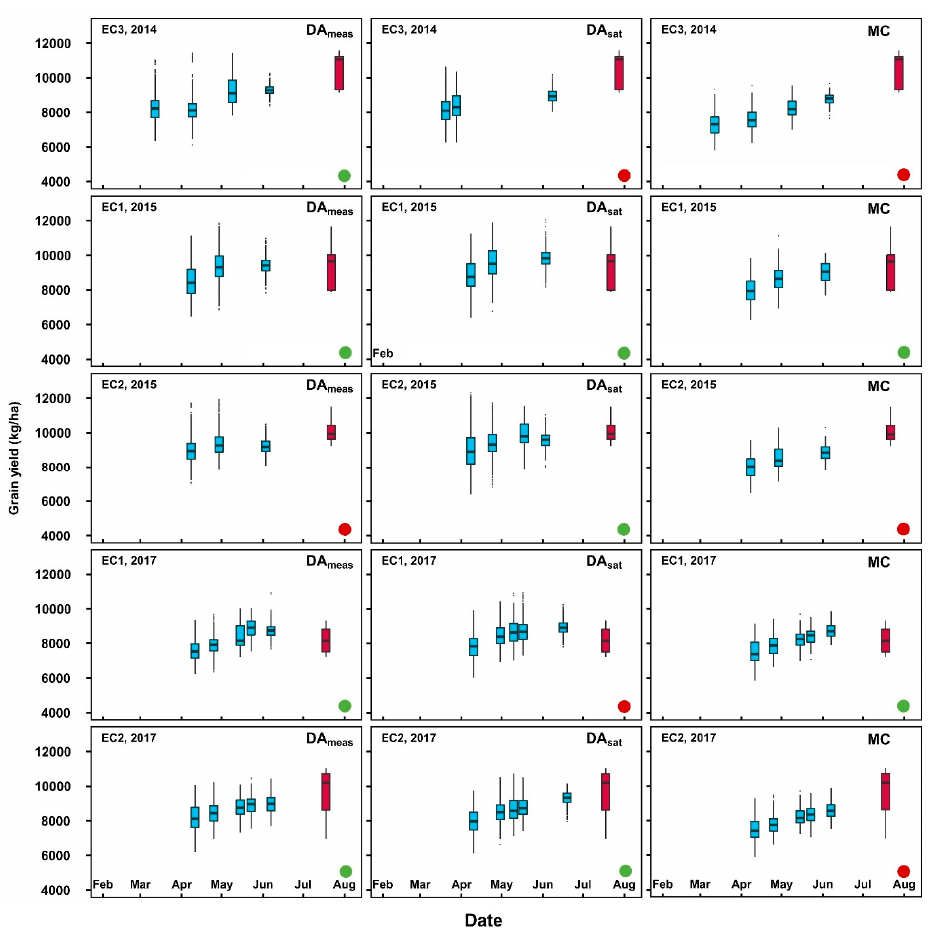
Figure 5. Wheat grain yield prediction with data from Kraichgau (KR). Left column : DA meas (data assimilation based on LAI measured in-situ), middle column : DA sat (data assimilation based on satellite observations of LAI) and right column : MC (Monte Carlo simulation). The red boxes show the measured yield. The dates of the blue boxes in DA meas and MC subplots show the dates of in-site measured LAI, and the dates of the blue boxes in DA sat subplots show the dates of remote sensing LAI. The dates of the red boxes correspond to the harvest date. Subplots with green circles signify that the median prediction of the last assimilation step is within the interquartile range of the measurements, otherwise, subplots have red circles.